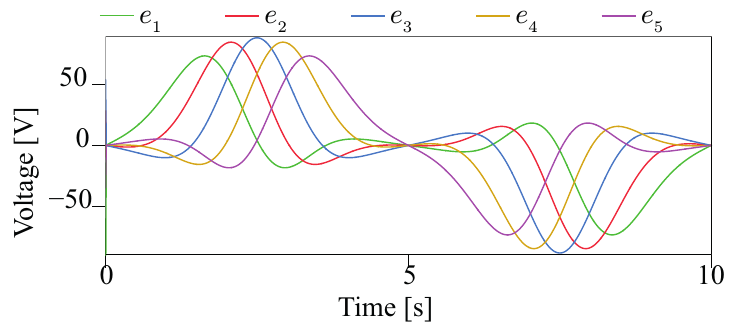
Figure 7. Voltage generated at the terminals’